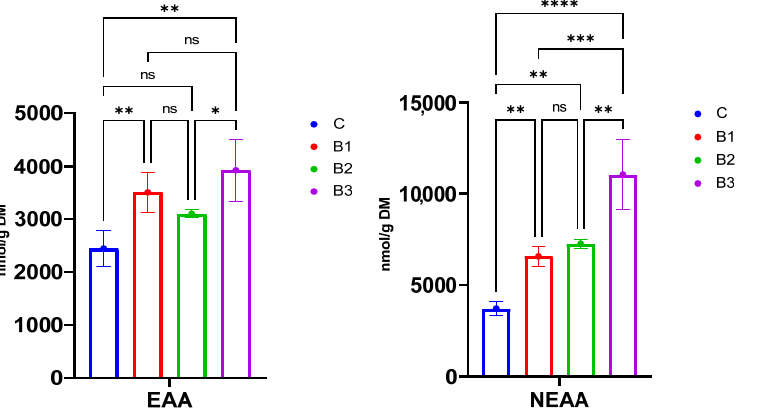
Figure 2. The total concentrations of essential (EAA) and non-essential amino acids (NEAA) in gluten-free mini sponge cakes fortified with broccoli leaf powder (BLP) extracted by method 1. C— control, B1—2.5% starch replacement with BLP, B2—5% starch replacement with BLP, and B3— 7.5% starch replacement with BLP, ns—not significant. (*) - p-value < 0.05, (**) - p-value < 0.01, (***) - p-value < 0.001